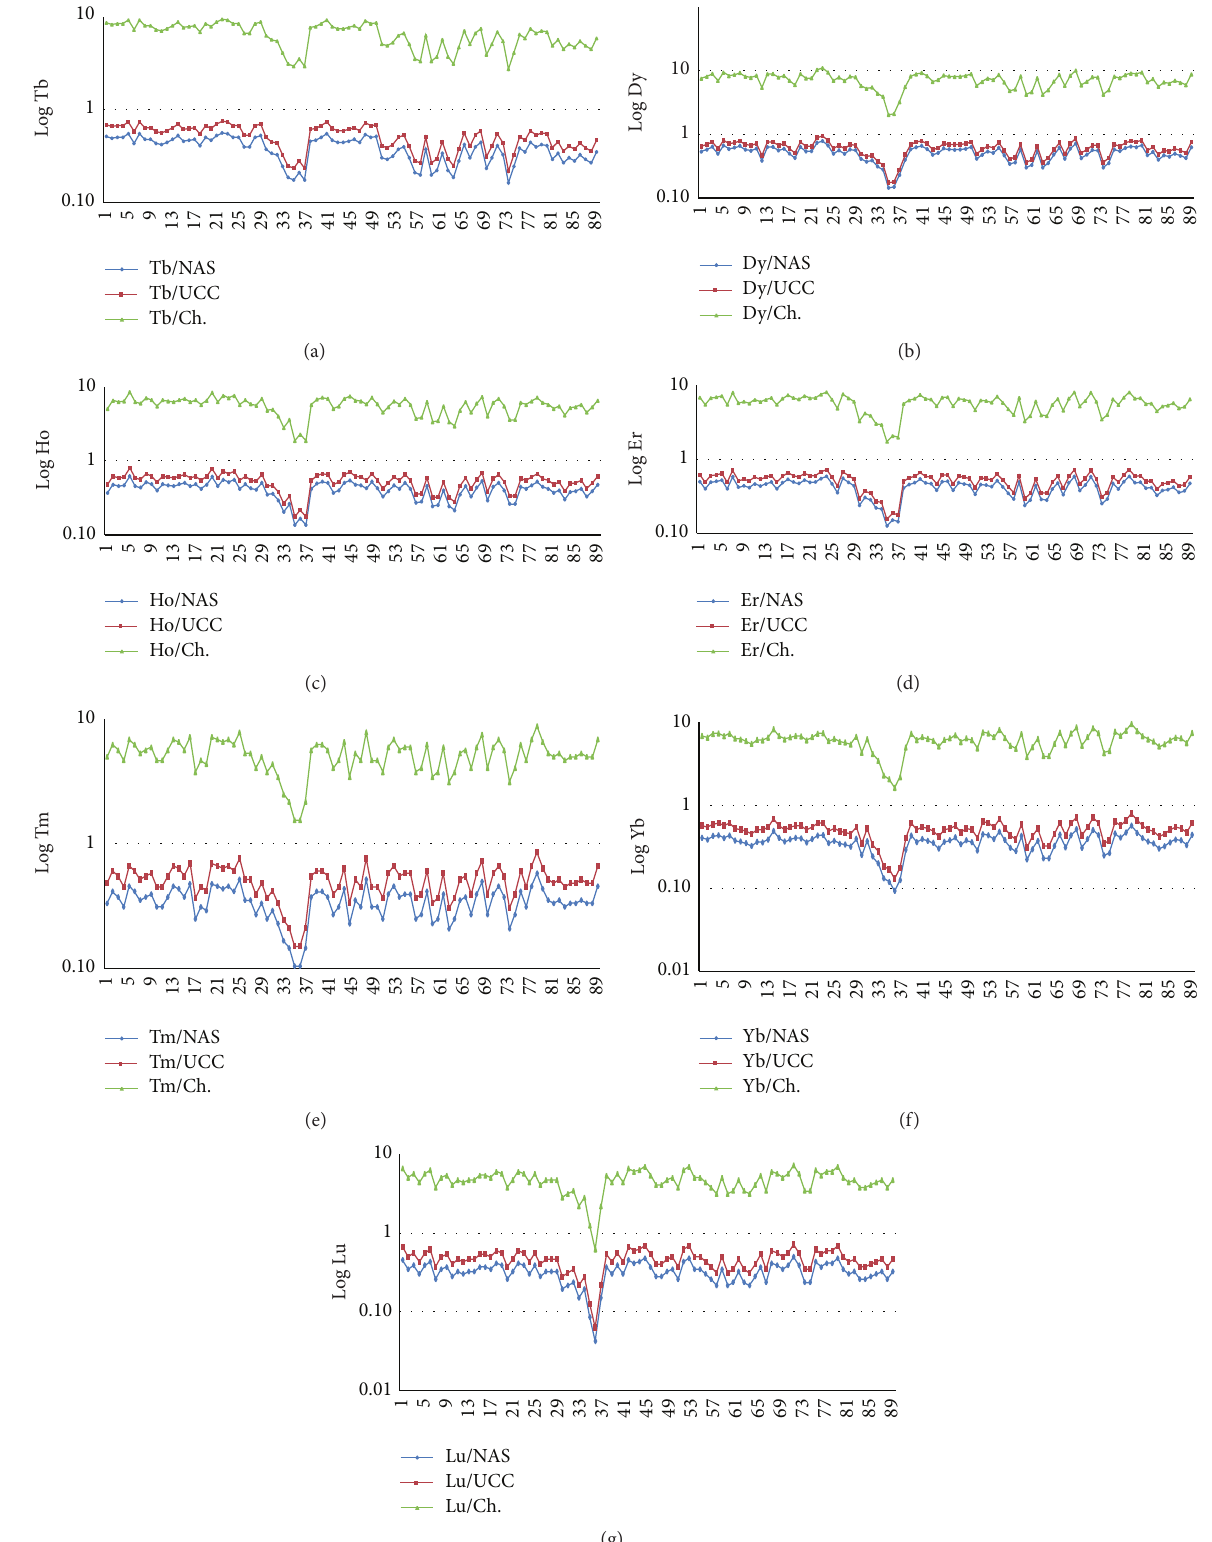
Figure 4: Normalized patterns of the HREE average concentrations ( 𝑁 = 90 ) of Euphrates River sediments in the NAS, UCC, and Ch. (a) Tb, (b) Dy, (c) Ho, (d) Er, (e) Tm, (f) Yb, and (g) Lu normalized